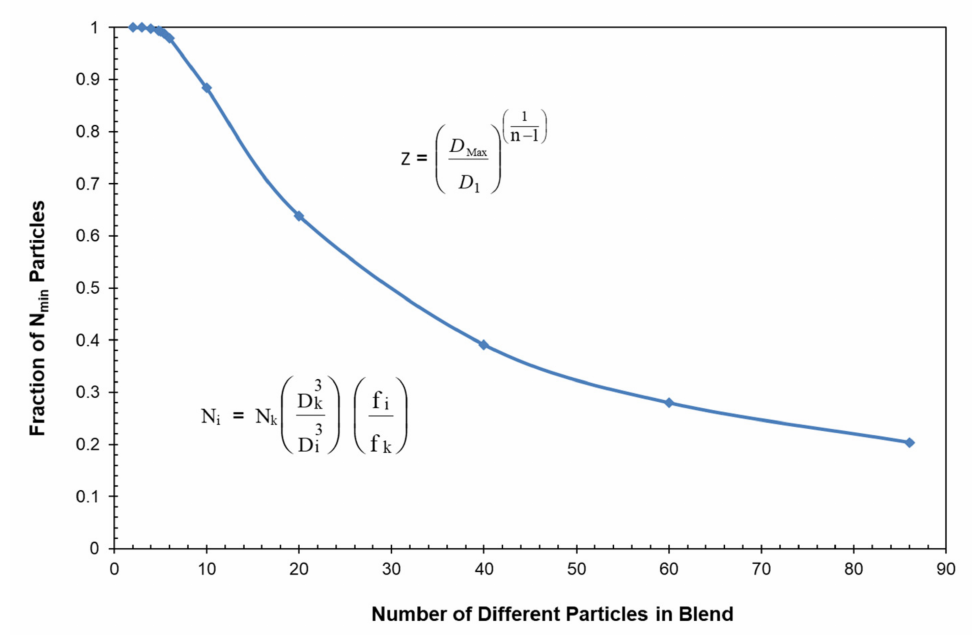
Figure 15. Fraction of number of small particles vs. number of different particles in constant slope